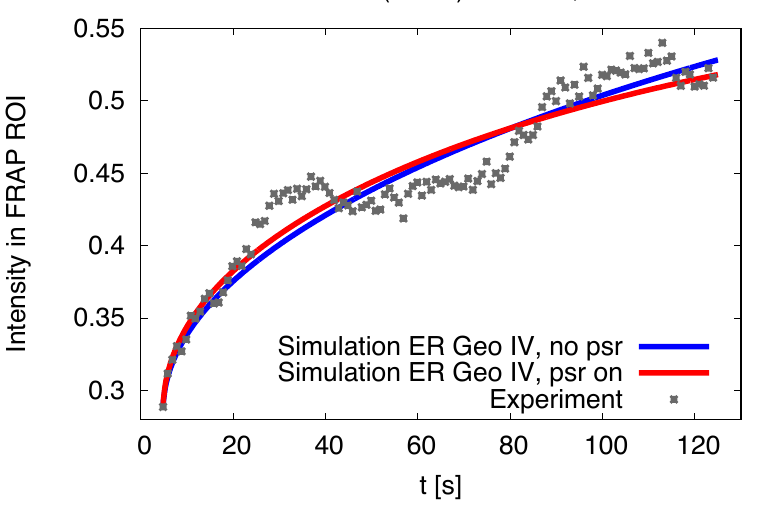
Figure 5. FRAP region intensity evaluation: experiment and simulation (computed with I of (12)), example of NS5A/Alone cell case. The curves depict the uprise of the concentration within the (bleached) FRAP ROI F for the in vitro and the in silico case. The in silico case inherits two different ways of theoretical description: The case r A p = 0 (“no psr”) neglects the measurement process induced signal reduction within (8), whereas the other case incorporates the afore estimated non-zero value of r A p (“psr on”, value cf. (11)). The in silico curves are that curves which arise for the estimated optimal value of D A for TMS # 0 of the NS5A/Alone cell case adapted to the reconstructed ER geometry E 4 ns5a